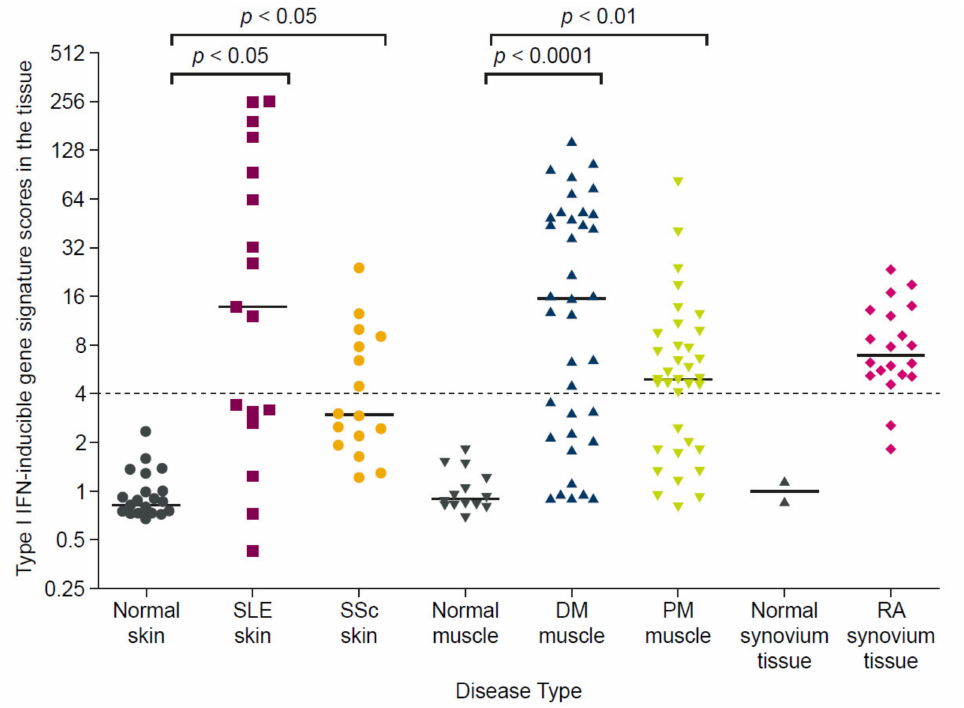
Figure 5. Elevated type I interferon gene signature expression in tissues of patients with SLE, SSc, DM, PM, and RA relative to healthy controls. The type I interferon gene signature score was calculated by measuring the expression of 5 type I IFN-inducible genes in disease target tissue and expressed as a fold-change relative to healthy controls. Horizontal bars represent the median values for each group and the gray dashed line indicates the threshold for signature positive or negative status. Lesional skin samples from patients with SLE ( n = 16) and SSc ( n = 16) had significantly greater IFNGS expression than samples from healthy controls ( n = 25) ( p < 0.05 for both). Muscle biopsy samples from patients with DM ( n = 37) and PM (n=36) had significantly greater IFNGS expression than those from healthy controls ( n = 14) ( p < 0.0001 and p < 0.01, respectively). No statistical test was performed to compare the IFNGS expression in synovium tissues from patients with RA versus healthy controls, owing to the small sample size ( n = 2 vs. n = 20). Figure reproduced from Higgs, B.W. et al. Patients with systemic lupus erythematosus, myositis, rheumatoid arthritis and scleroderma share activation of a common type I interferon pathway. Ann Rheum Dis 2011, 70, (11), 2029-36. 2021 [30], with permission from BMJ Publishing Group Ltd. DM, dermatomyositis; IFN, interferon; PM, polymyositis; RA, rheumatoid arthritis; SLE, systemic lupus erythematosus; SSc, systemic